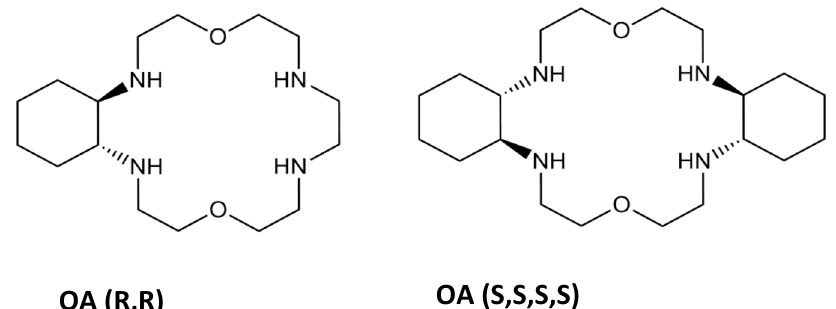
Figure 13. Structure of the oxaazamacrocycle receptors OA(R,R) and OA(S,S,S,S) [53].